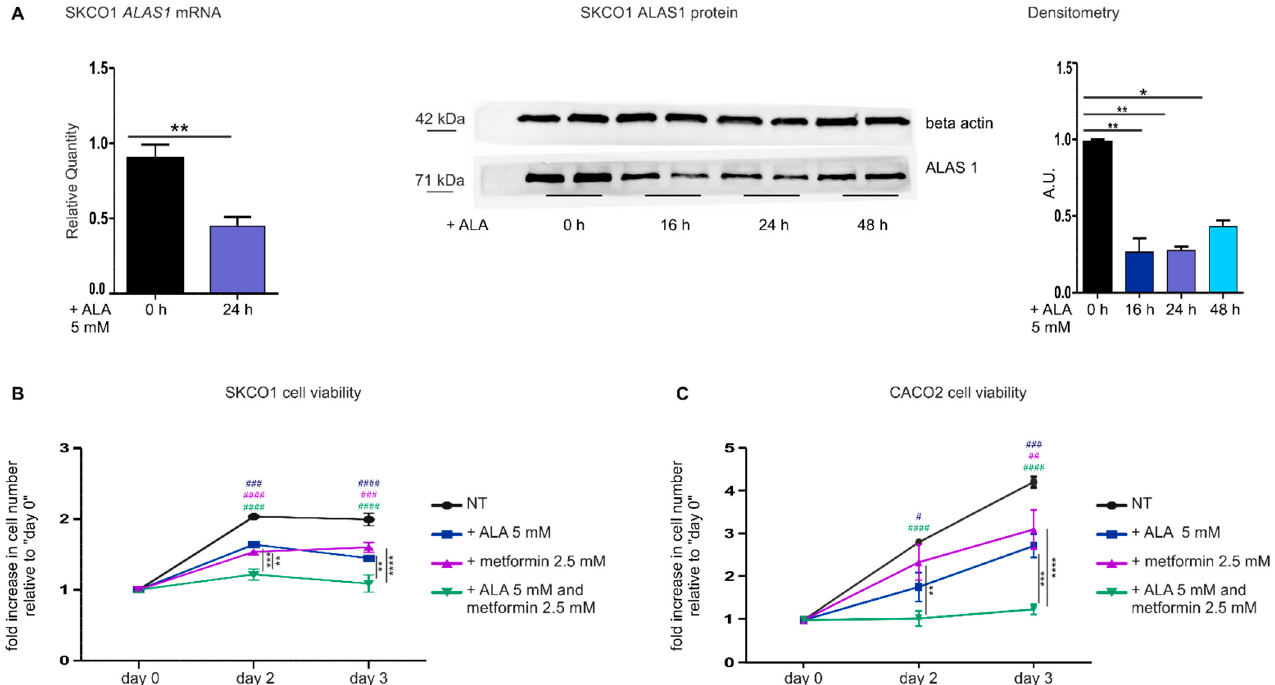
Figure 2. The down-modulation of the heme synthesis-export system, obtained by ALA treatment, sensitizes colorectal cancer cells to metformin. ( A ) qRT-PCR analysis (on the left ) and Western blot analysis (on the right ) of ALAS1 expression in SKCO1 cells upon ALA administration. For qRT-PCR analysis, ALAS1 expression was measured on SKCO1 cells untreated or treated with 5 mM ALA for 24 h. Transcript abundance is normalized on beta-actin mRNA expression and expressed as a fold increase over a calibrator sample. For statistical analyses, a Student- t -test was used. Data represent mean ± SEM, n = 5 biological replicates, ** p < 0.01. For western blot analysis, untreated cells are compared to cells treated with 5 mM ALA for 16, 24 and 48 h. Beta-actin expression is shown as a loading control. Band intensities were measured by densitometry and normalized to beta-actin expression. Densitometry data represent mean SEM, n = 2 biological replicates. ± For statistical analysis, a one-way ANOVA analysis of variance was performed, followed by the Bonferroni correction for multiple groups comparisons; * p < 0.05, ** p < 0.01. ( B , C ) Cell viability of SKCO1 ( B ) and CACO2 ( C ) cells measured at different time points as a readout of cell proliferation. Untreated (NT) cells are compared to cells treated with ALA, metformin or ALA + metformin. Drug administration occurred at day 1 of cell proliferation. Cell viability is measured as a fold increase over an untreated calibrator sample and expressed relative to day 0. Data represent mean SEM, ± n = 5 (SKCO1) or 4 (CACO2) biological replicates. For statistical analyses, a two-way analysis of variance was performed, followed by the Bonferroni correction for multiple groups comparisons; * symbols are used to indicate statistical significance when cells treated with ALA + metformin are compared to cells treated with metformin or ALA alone; # symbols are used to indicate statistical significance when treated cells are compared to untreated cells; # p < 0.05, ** or ## p < 0.01, *** or ### p < 0.001, **** or #### p <